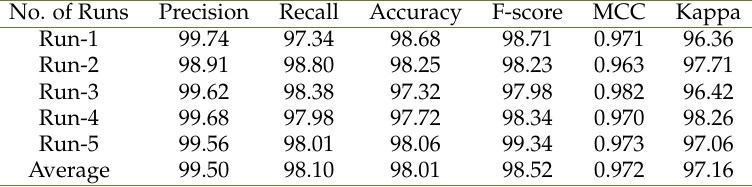
Table 3. Result Analysis of the Proposed EMACC-MR Method on the Activity Recognition